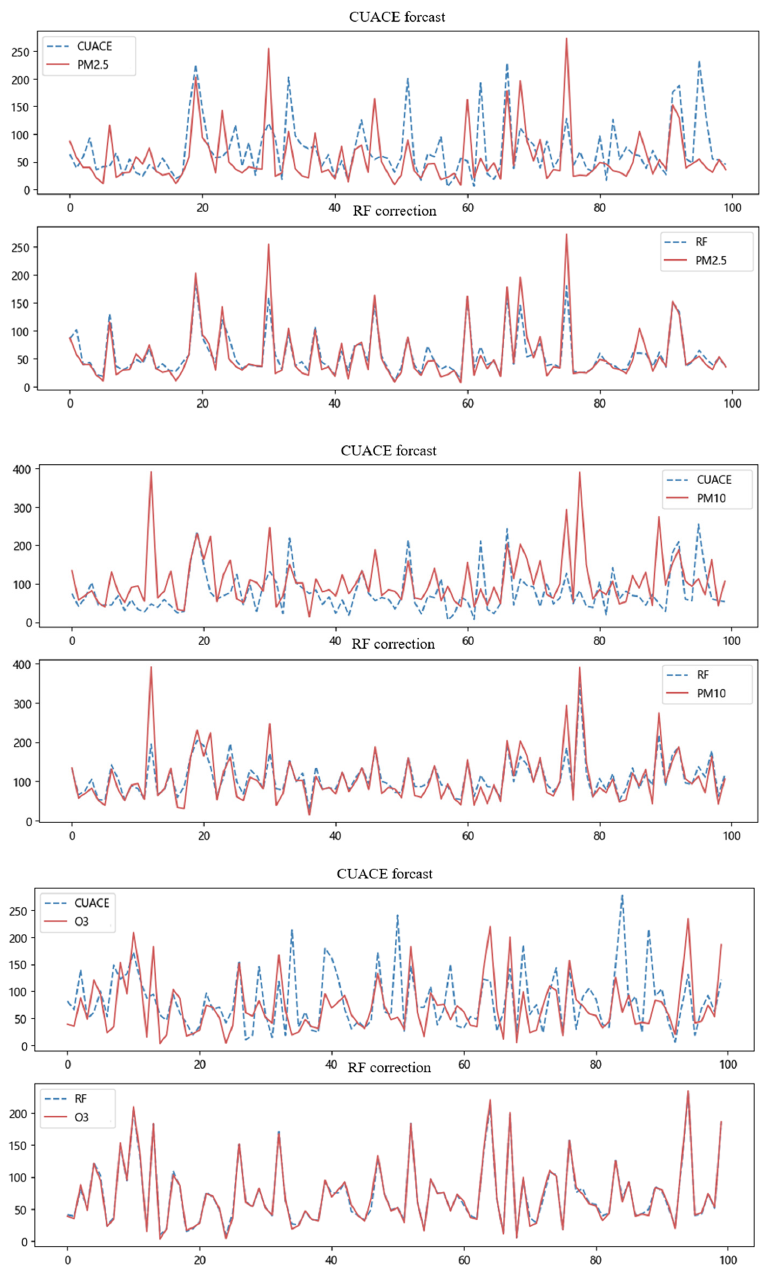
Figure 6. RF algorithm correction results.